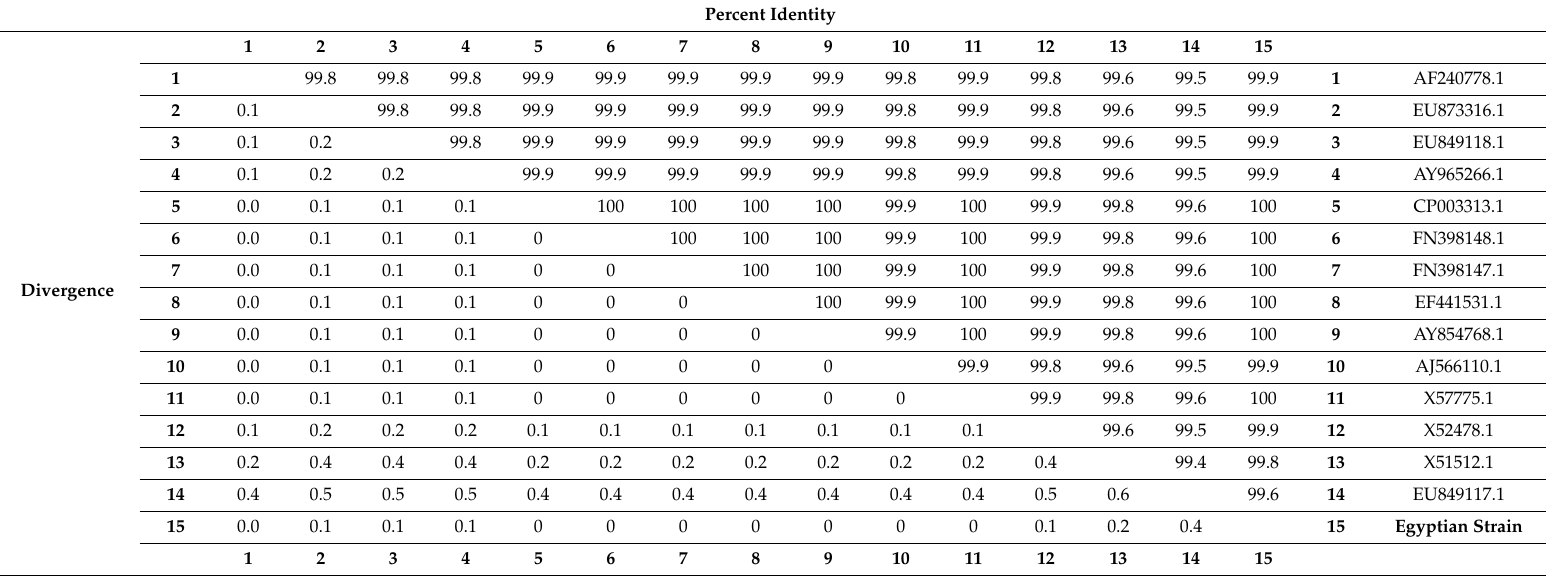
Table 6. Nucleotides and amino acid identity and sequence distance of P. multocida serotype B2 tox A gene between the isolated Egyptian strain and di ff erent strains uploaded in the gene